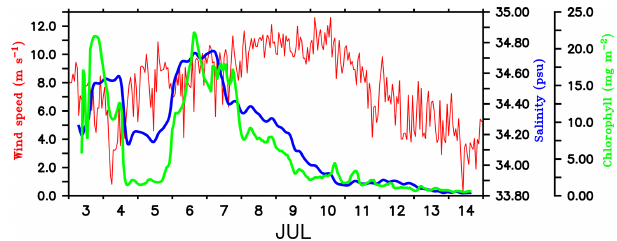
Figure 7. Time series of wind speed (ms − 1 ; red) from shipboard AWS at TSE (89 ◦ E, 8 ◦ N). Surface salinity (psu; blue) and to- tal chlorophyll integrated over the mixed layer (mgm − 2 ; green) is from SG620, deployed at TSE. MLD is calculated as the depth where density is equal to the sea surface density plus an increase in density equivalent to a reduction in temperature of 0.8 ◦